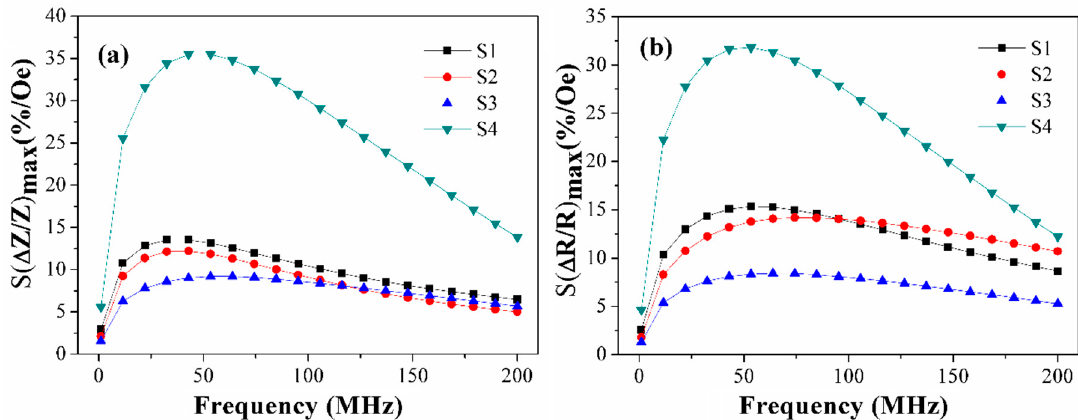
Figure 8. Frequency dependence of the sensitivity of the MI ratio for ( a ) total impedance and ( b ) its real part for Co 75 Fe 10 Ni 2 Si 8 B 5 meander samples.